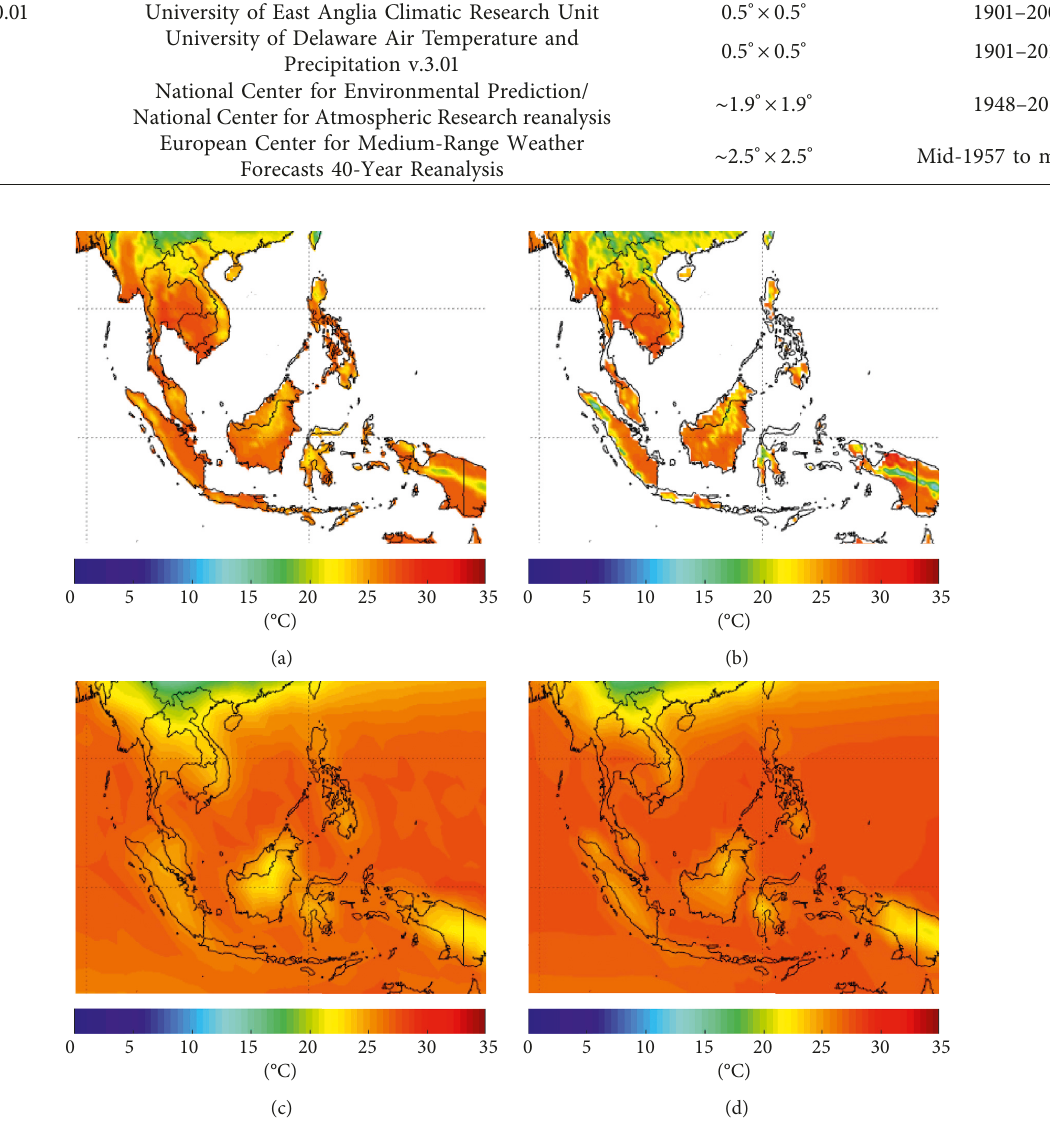
Figure 2: Comparison of the mean annual temperatures ( ° C) for years 1960–1999 of (a) CRU, (b) UD, (c) NCEP, and (d)